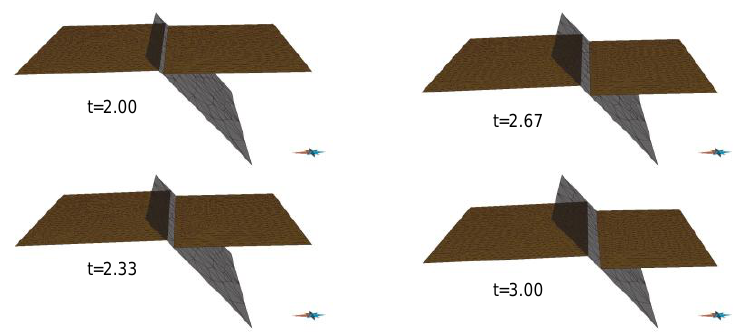
Figure 11. The geological horizon, B, in time interval [2, 3] .